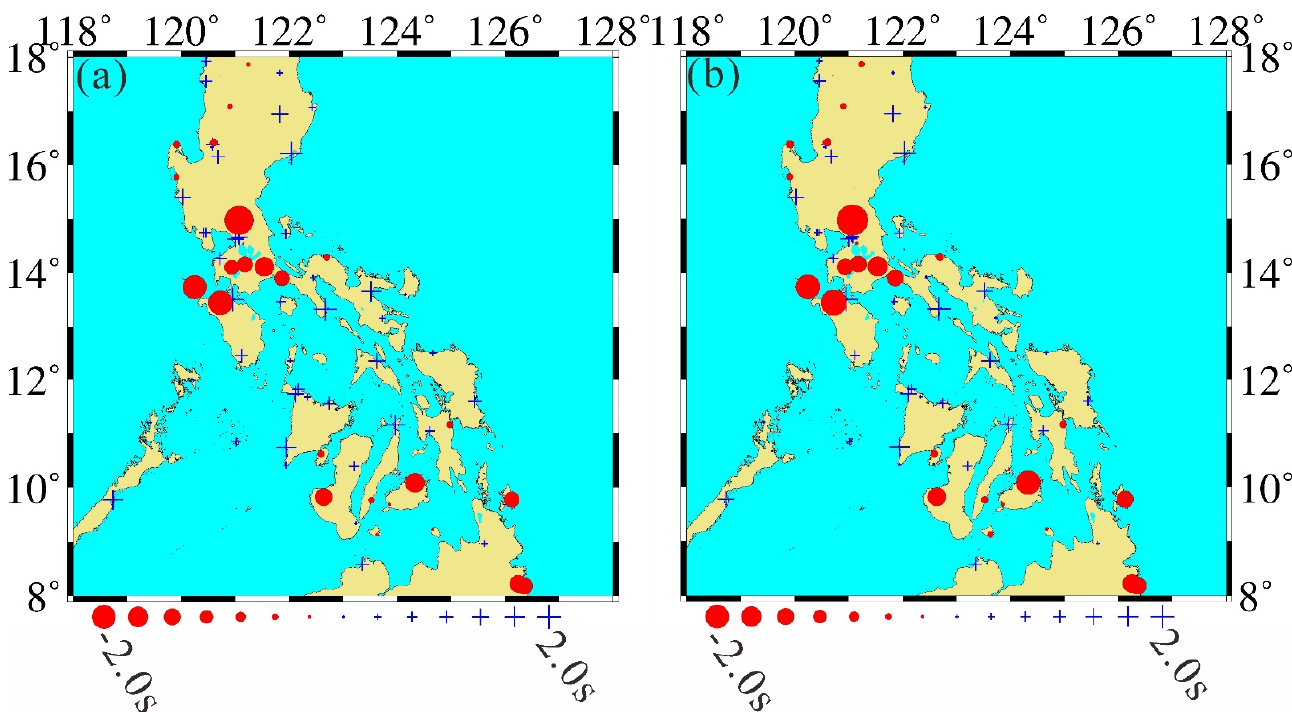
Figure 3. Distribution map of mean value of relative travel time residuals for each receiver ( a ) before crustal correction ( b ) after crustal correction.